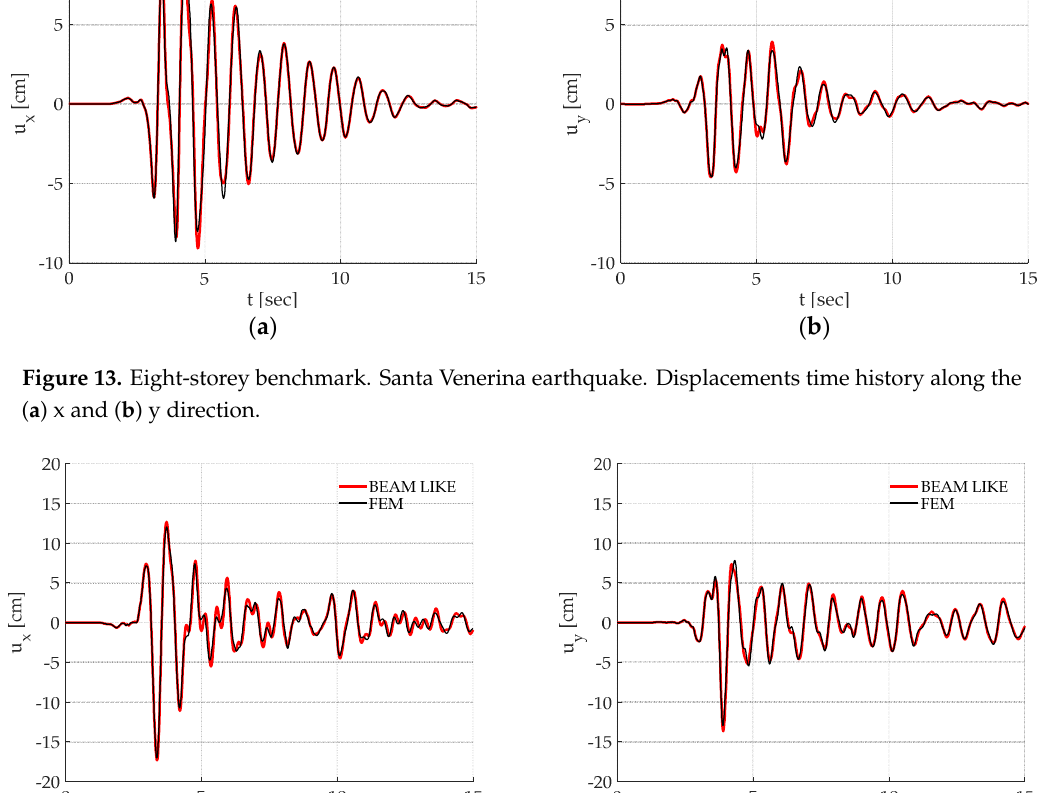
Figure 12. Eight -storey benchmark. Modal shapes comparison between the ( a ) FEM and ( b ) beam- like models.